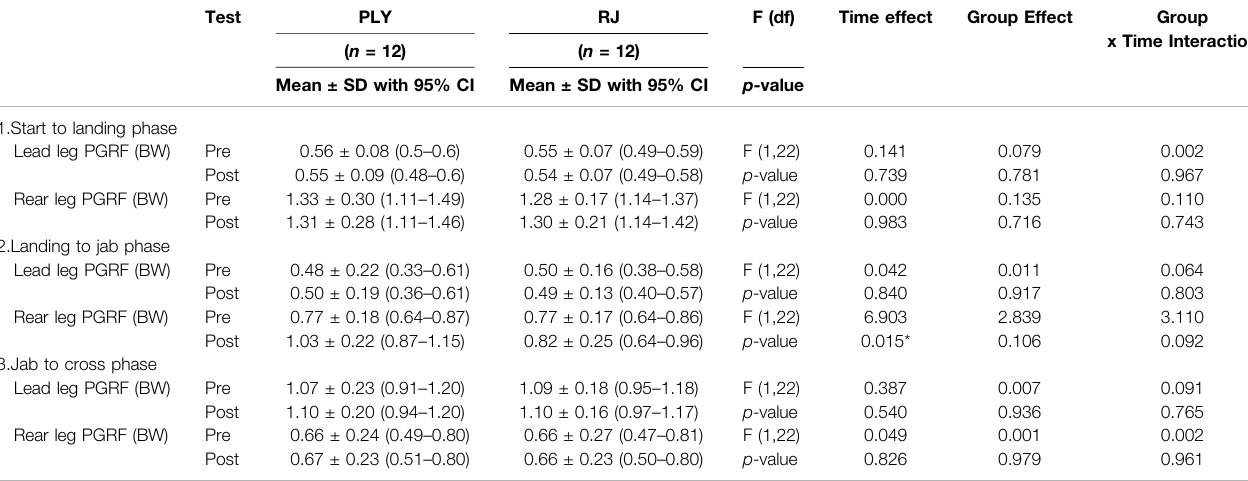
TABLE 5 | Lead leg and rear leg ground reaction force during jab-cross punch before and after PLY or J.R. training. Test PLY RJ F (df) Time effect Group Effect Group